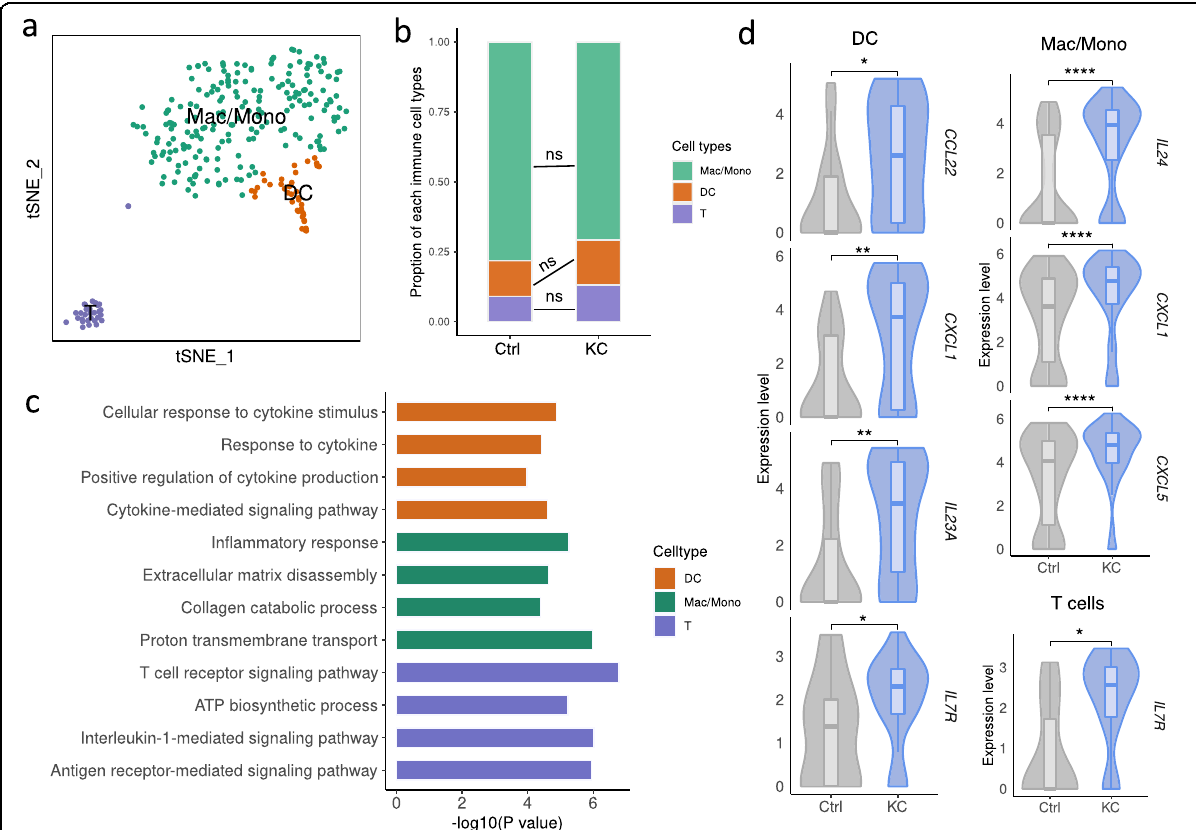
Fig. 5 In fl ammatory signals in keratoconus corneas contributed by immune cells. a t-SNE plot showing three immune cell types identi fi ed in KC and Ctrl samples. b Proportion of each immune cell type in KC and Ctrl samples. ns, no signi fi cance (Student ’ s t -test). c Representative GO terms of keratoconus-upregulated genes in each immune cell type. d Violin plots showing representative differentially expressed cytokines in keratoconus immune cells. * P < 0.05, ** P < 0.001, **** P < 0.0001 (two-sided Wilcoxon rank-sum